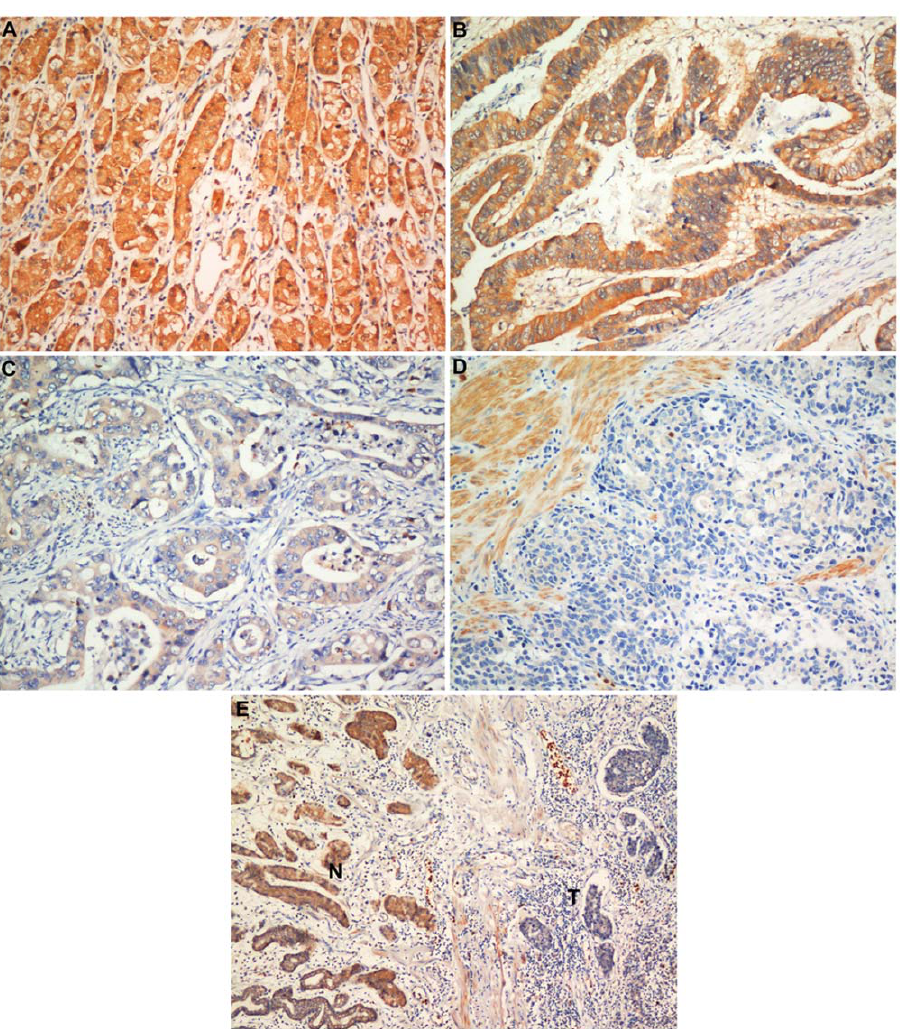
Figure 3. Immunohistochemical detection of the AP-2 a protein expression in gastric cancer and surrounding non-tumor tissues. (A) Normal gastric tissues, scored as AP-2 a ( +++ ); (B) Well-differentiated gastric cancer, scored as AP-2 a ( ++ ) according to the criteria defined in material and methods section; (C) moderately differentiated gastric cancer, scored as AP-2 a ( + ); (D) poorly differentiated gastric cancer, scored as AP-2 a ( 2 ); (E) Immunostaining of gastric cancer and adjacent non-tumor tissues showing a sharp contrast between infiltrative tumor areas of negative staining and the adjacent tissue of positive staining. Original magnification: A–D 6 200; E 6 100.